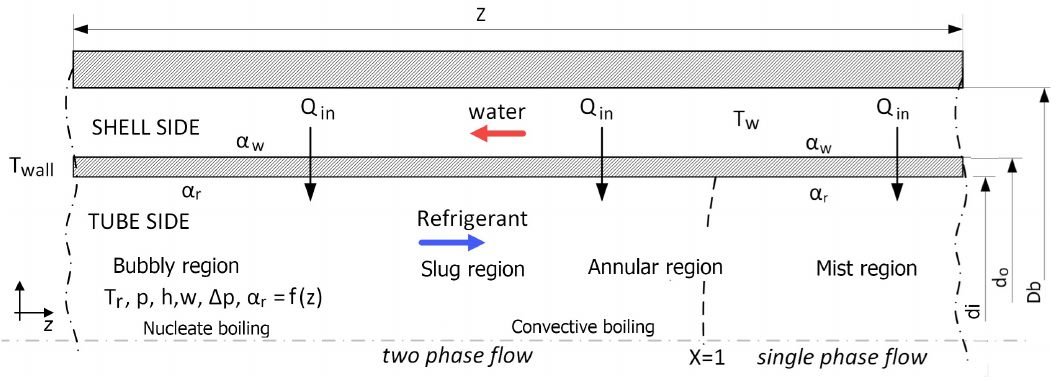
Figure 1. Mathematical model of the evaporator tube.